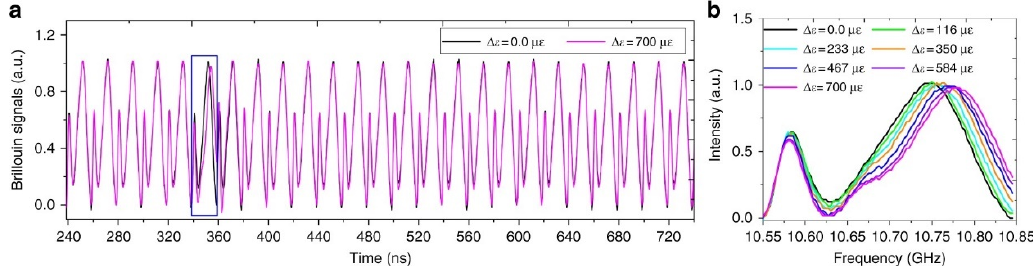
Figure 24. ( a ) Transmitted probe power as a function of time, showing a sequence of BGSs impressed on it due to interaction with the pump pulse. ( b ) Zoomed view of the portion of the probe